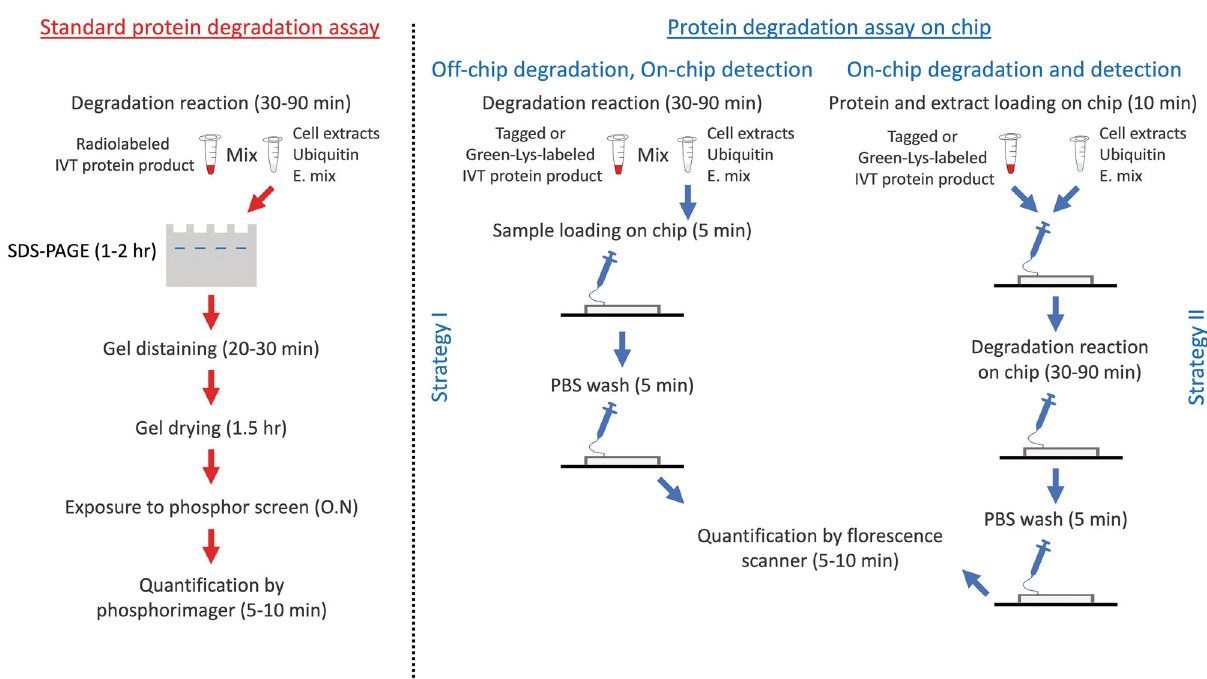
Fig. 7 Schematic illustration of standard vs. two on-chip assays for protein degradation. The purpose of all methods is to assay protein degradation of IVT protein products in reaction mix comprising cell-free extracts, recombinant ubiquitin and energy-regeneration mixture (E. mix). The standard assay (red pipeline) is typically radioactive. An 35 S-labeled IVT product (1 – 2 µ l) is mixed with 20 – 50 µ l reaction mixture, and incubated for 30 – 90 min. Each time point an aliquot (~5 µ l) of the reaction mix is harvested. Samples are denatured and resolved by SDS-PAGE. Following drying, the gel is exposed to